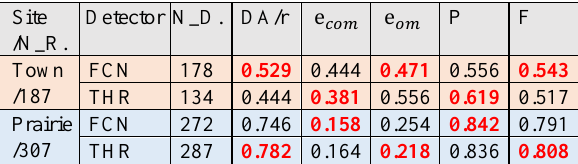
Table 1. The experiment results in the two test areas. N_R. and N_D. refer to the number of the reference and detected treetops. DA/r is detection accuracy or recall ratio. e 𝑐𝑜𝑚 and e 𝑜𝑚 are the commission error and the omission error while precision and F- score are represented as P and F. The best numbers are red and